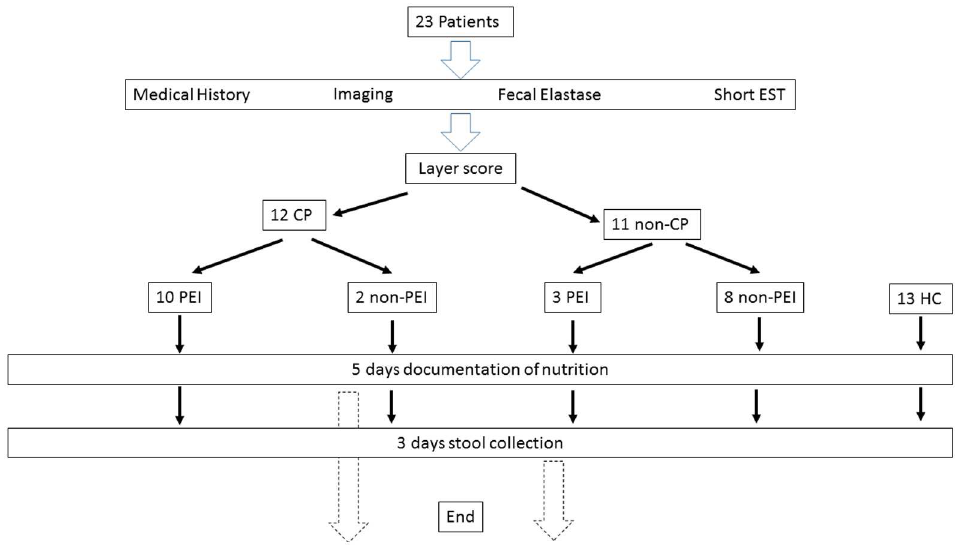
Fig 1. Flowchart of the retrospective study from a database for chronic pancreatitis. Short EST = Short endoscopic secretin test. The Layer score bases on imaging,pancreas function testing and clinical history. Similar to the Mayo score it differentiates betweenCP (chronicpancreatitis) and non-CP(= result of scoring not suggestivefor chronicpancreatitis). PEI = pancreatic exocrineinsufficiency. We definedgold standardfor PEI as Bicarbonate concentration < 80 mmol/l in the short endoscopic secretin test as it is a direct pancreas function test. Consecutively a test result of bicarbonate concentration in duodenaljuice > 80 mmol/l is not suggestivefor pancreatic exocrineinsufficiency(non-PEI). HC =